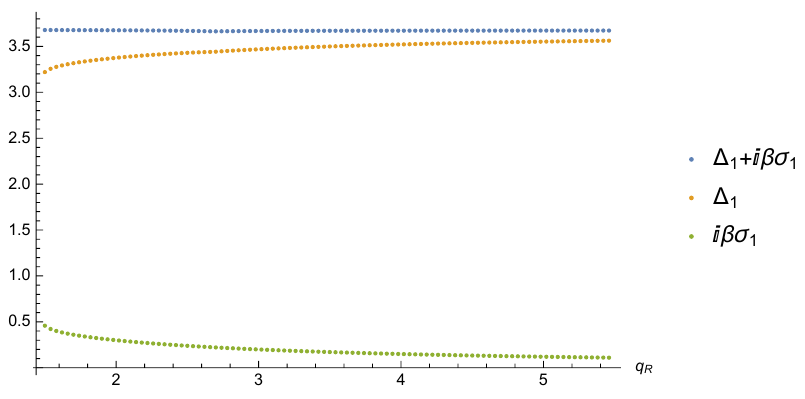
Figure 6 . Numerical values of ˆ∆ 1 , i ˆ β ˆ σ 1 and the combination ˆ∆ 1 + i ˆ β ˆ σ 1 for Case 3 as a function of q R